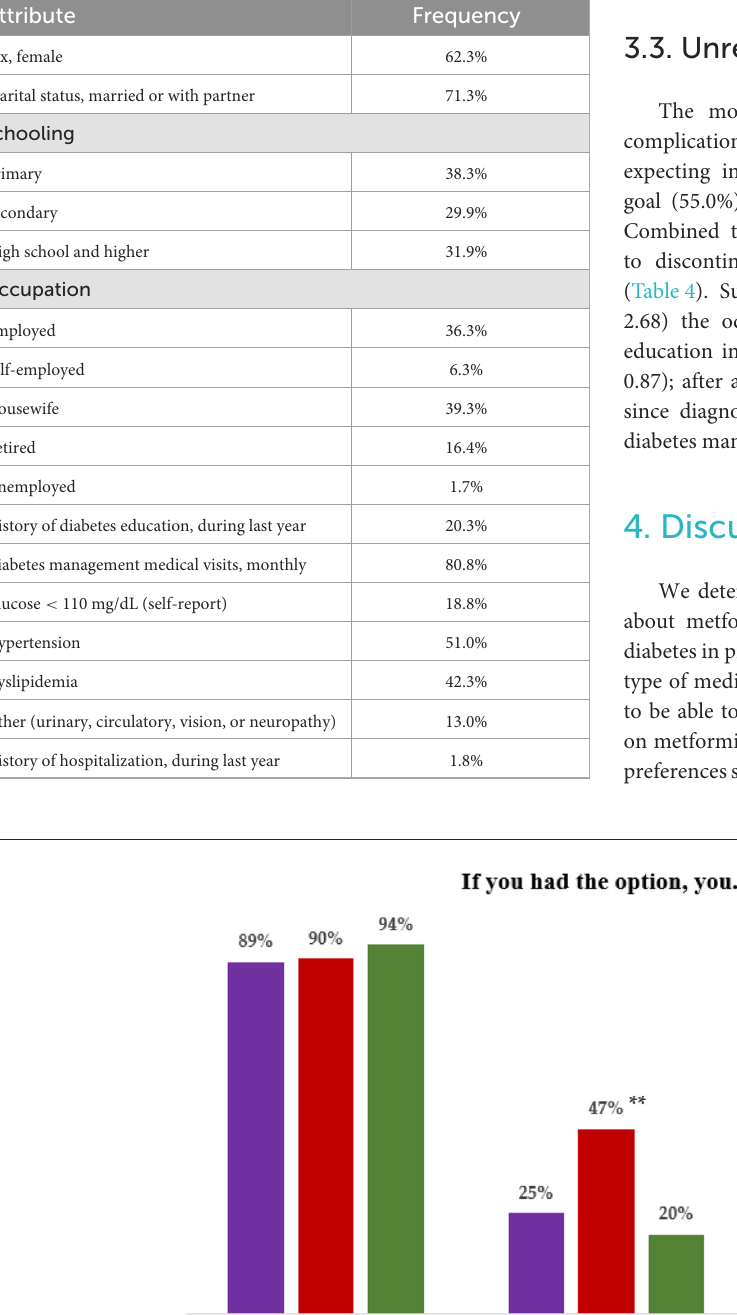
FrontiersinPublicHealth